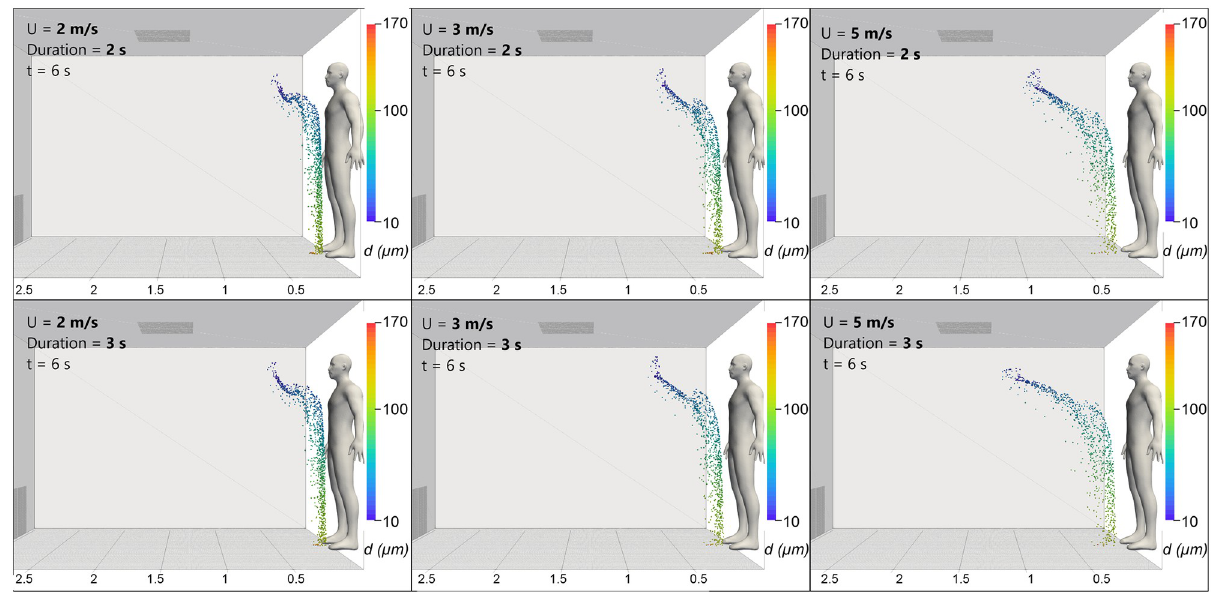
Fig 6. CFD simulations: Breathing. Comparison of droplet cloud shape and positions at t = 6 s after exhalation initiation for a range of exhalation velocities and durations as shown.